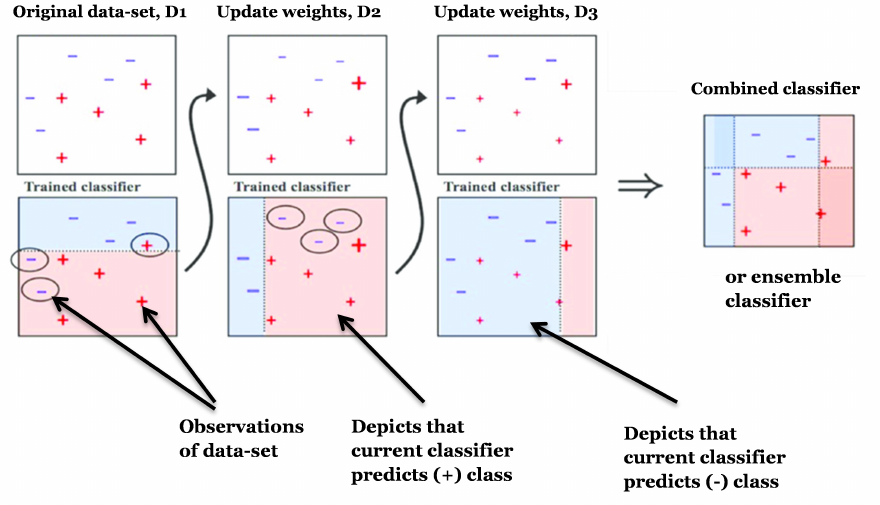
Figure 6. Illustration of Ada-boost Architecture Steps. “Adapted from [51]. (1997), Sodhi,